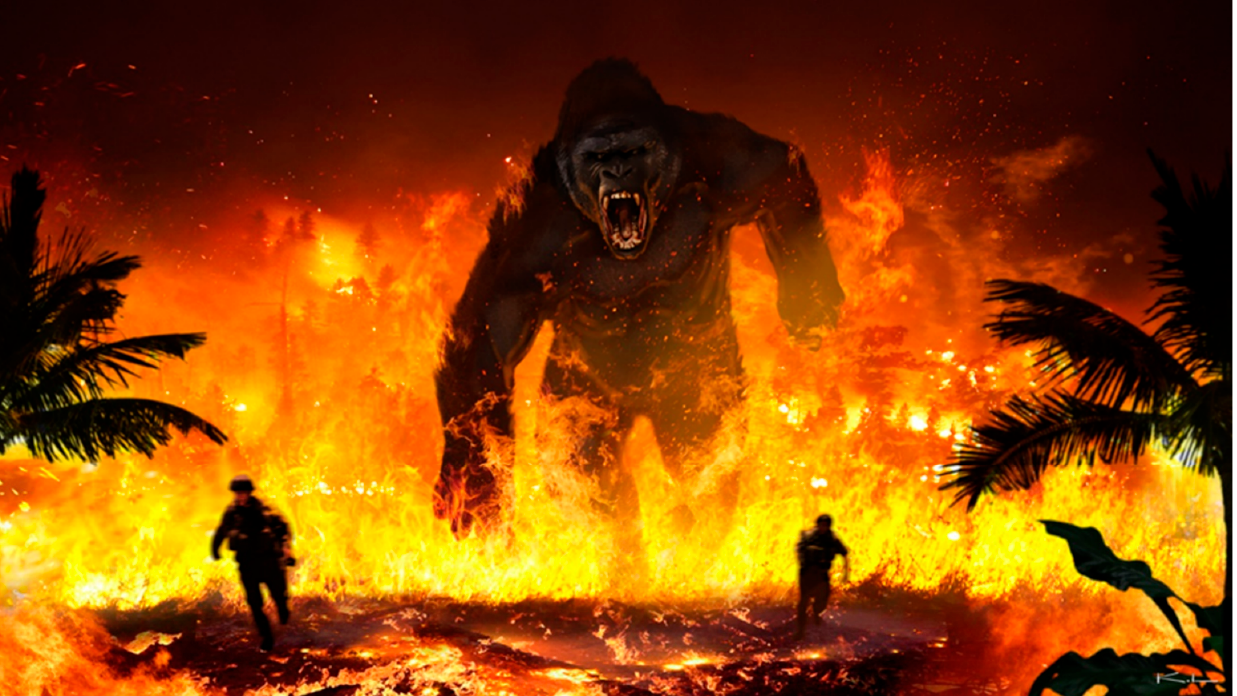
Figure 22. King Kong is cremated as in Indian religions (2017). https://karllindberg.artstation.com/projects/4vqQL (accessed on 1 January 2021).